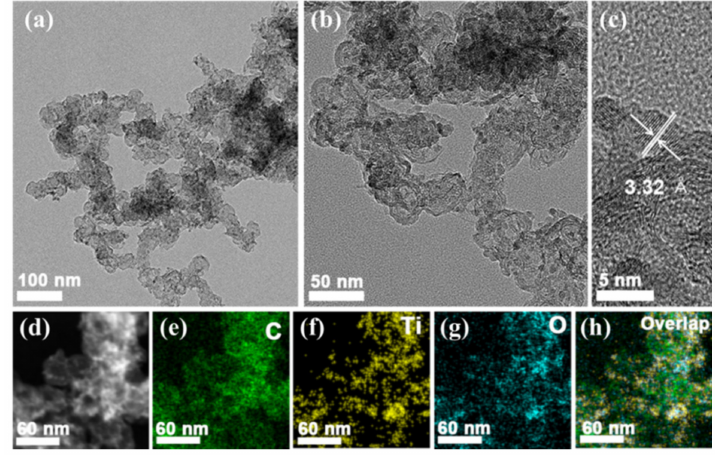
Figure 1. ( a , b ) TEM images of TiO 2 -SP at different magnifications. ( c ) HR-TEM image of TiO 2 -SP. ( d ) HAADF-STEM image and ( e–h ) the corresponding EDS elemental mapping images of TiO 2 -SP.